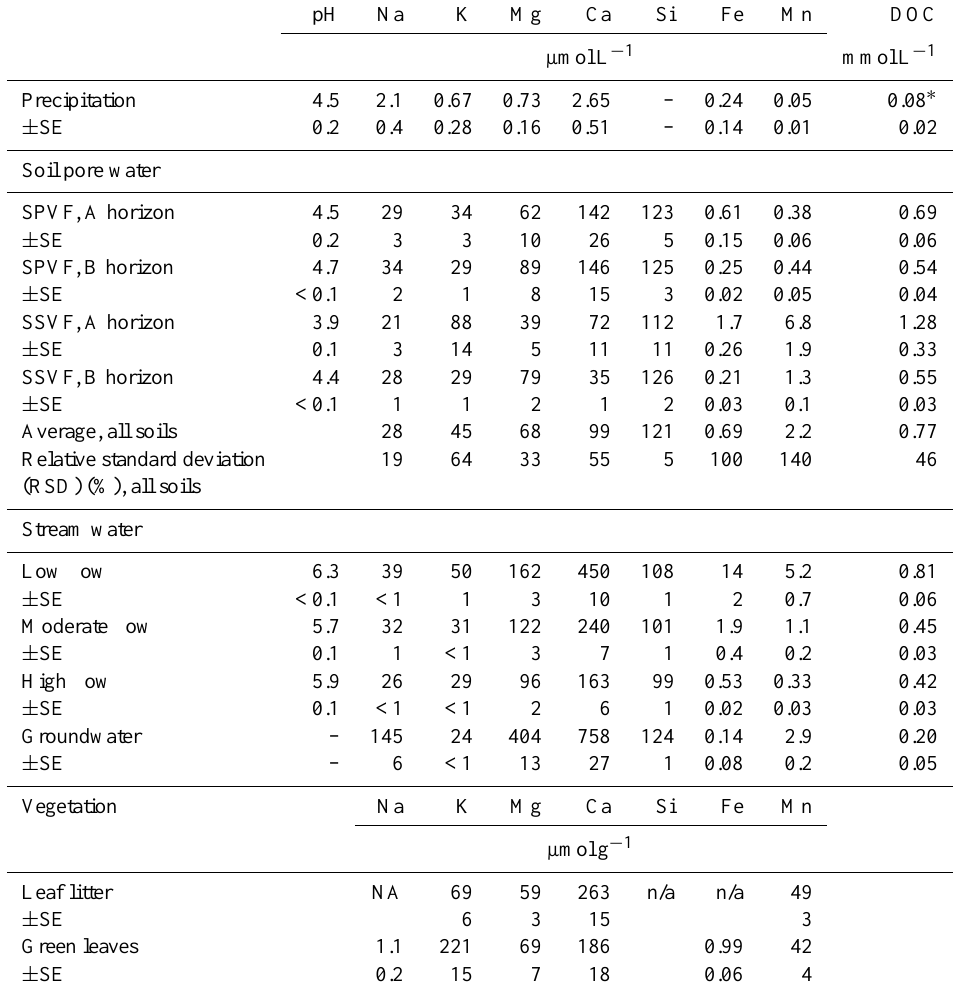
Table 2. Element concentrations ( ± standard error) in water (precipitation, soil pore water, stream water, groundwater) and vegetation (green leaves, leaf litter) averaged over all available data collected from the Susquehanna Shale Hills Critical Zone Observatory in Pennsylvania, USA, between 2006 and